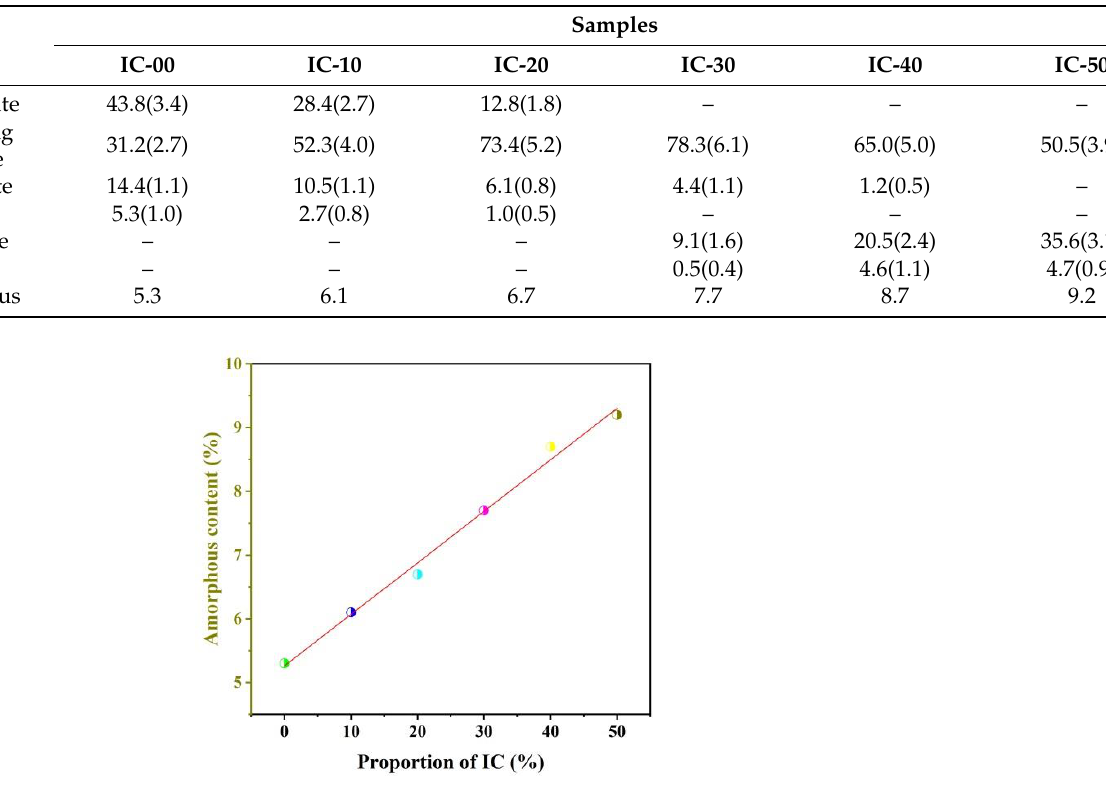
Figure 4. Proportion of IC vs. amorphous content.